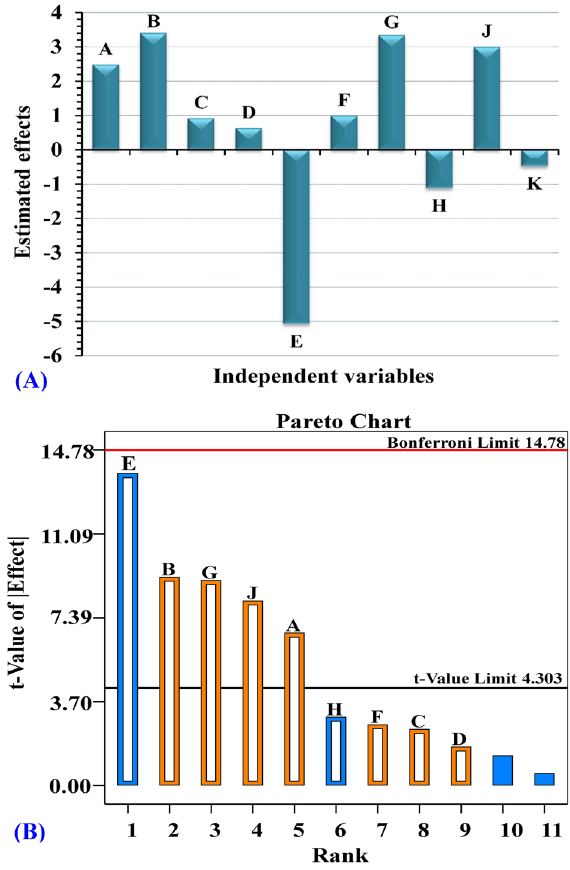
Figure 7. ( A ) Estimated effects of independent factors, The independent factors are: A (medium volume; mL/250 mL conical flask), B (pH), C (incubation time; days), D (inoculum size; %, v/v), E (Cantaloupe juice; %, v/v), F (citric acid; g/L); G (peptone; g/L), H (yeast extract; g/L), J (temperature; °C), K (Na 2 HPO 4 ; g/L). ( B ) Pareto chart shows the order and significance of the factors on the bacterial nanocellulose production by Bacillus sp . strain SEE-3 using Plackett–Burman design “the blue colors represent negative effects and the orange color represent positive effects”. This figure was created by using Design Expert version 12 for Windows